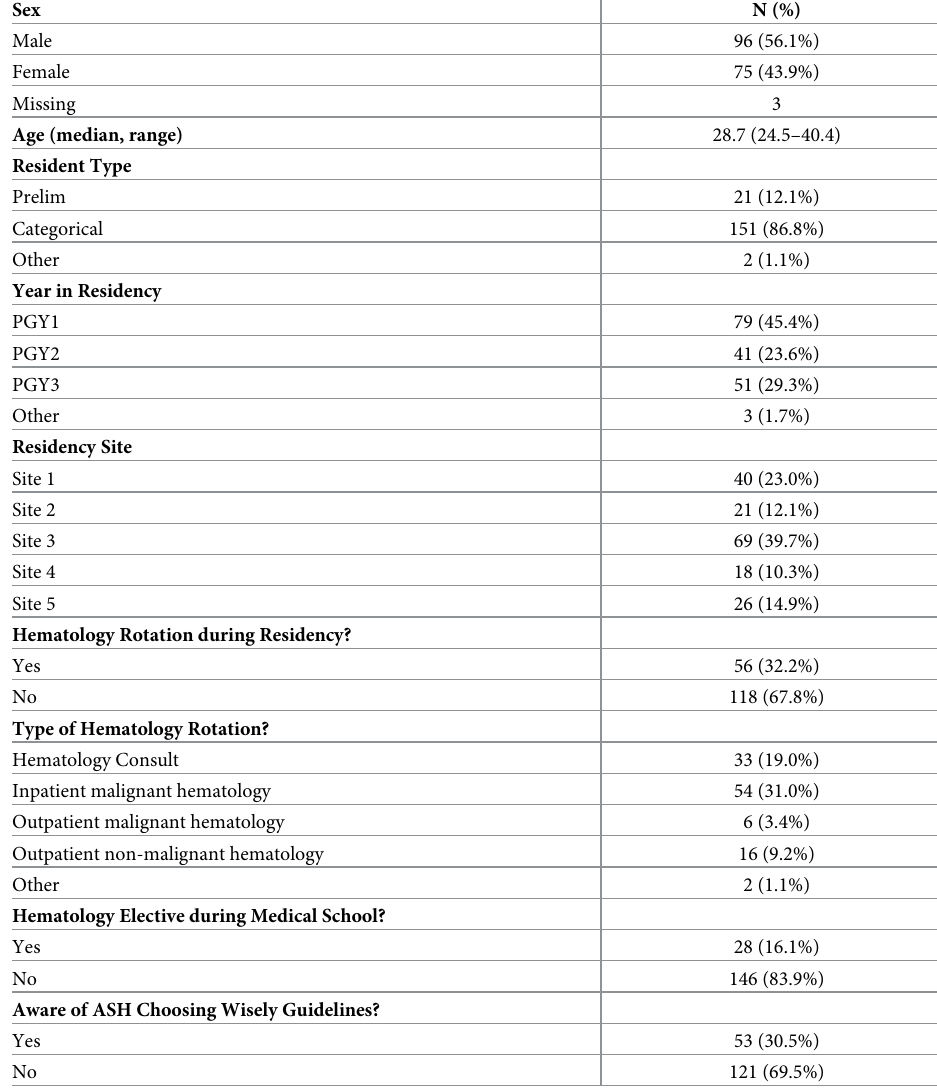
Table 1. Demographics of complete